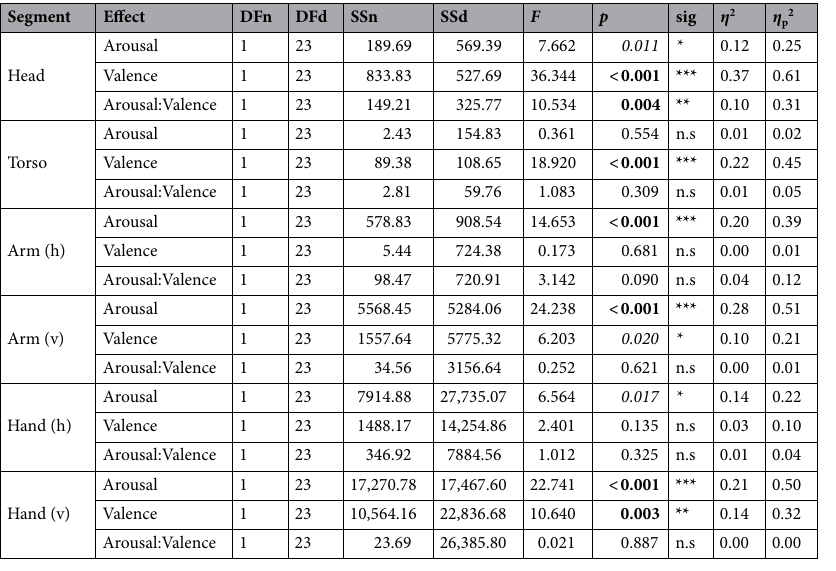
Table 2. Repeated-measures ANOVA results for the emotion dimensions. Summary of the two-way repeated measures ANOVA for each segment, after controlling for body diversity using the neutral emotion condition. Measures of effect size include general eta squared (η 2 ) and partial eta squared (η p 2 ). P values that failed to reach significance after Bonferroni corrections are in italics . P values that retained significance after Bonferroni corrections are in bold . * p < .05, ** p < .01, *** p < .001, n.s., not significant. Abbreviations: DFd, denominator degrees of freedom; DFn, numerator degrees of freedom; (h), horizontal; ges, general eta squared; n.s., not significant; pes, partial eta squared); sig, significance level; SSd, sum of squares denominator; SSn, sum of squares numerator; (v),